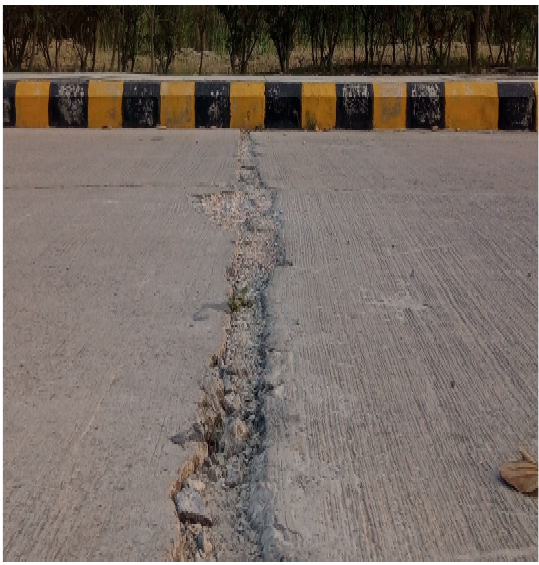
Figure 7(a) . Actual image of road pavement.